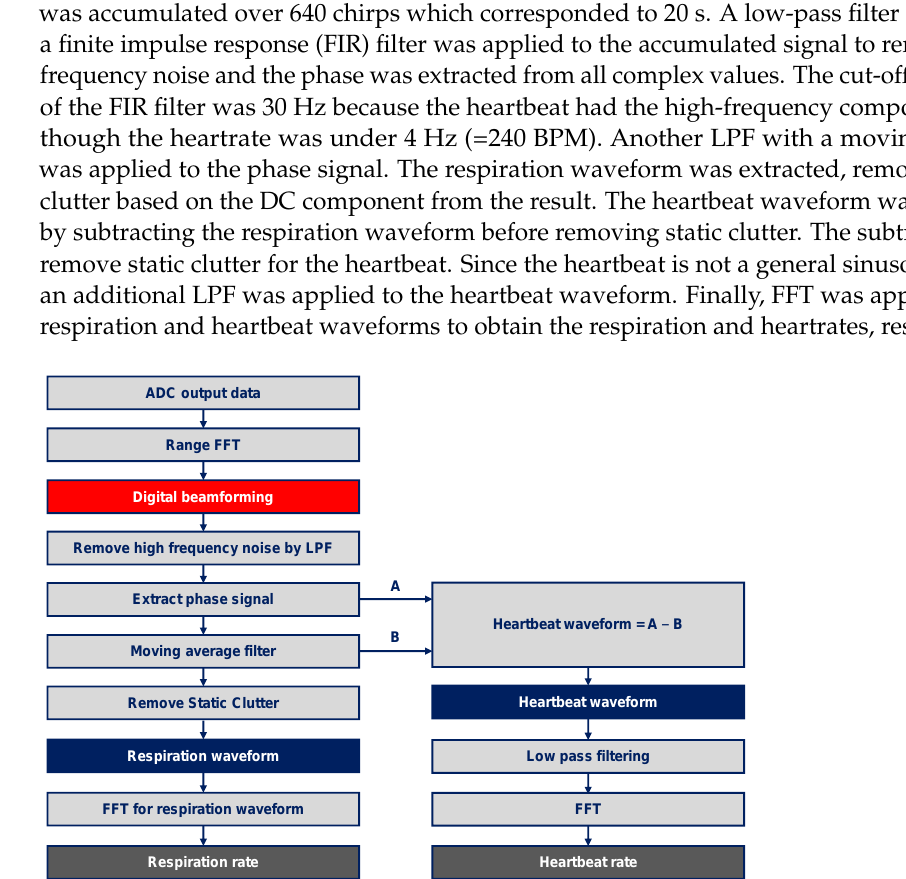
Figure 2. ( a ) The 12-virtual array RX channels generated by 3-TX and 4-sRX antennas and; ( b ) the radar cube generated by 12-virtual array RX channels.